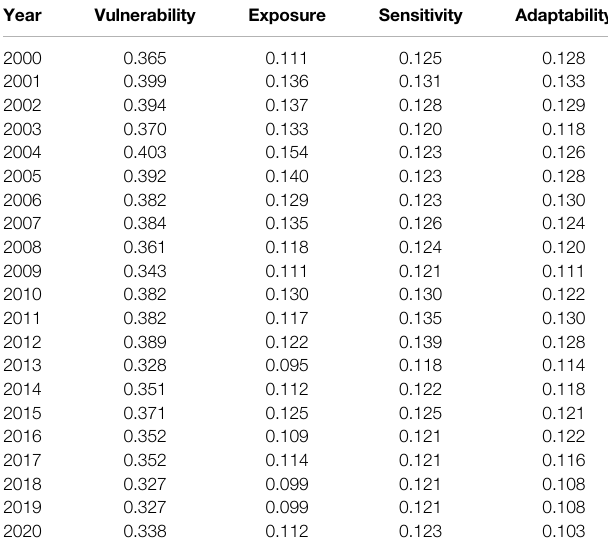
TABLE 3 | Average vulnerability of agricultural fl oods in China from 2000 to